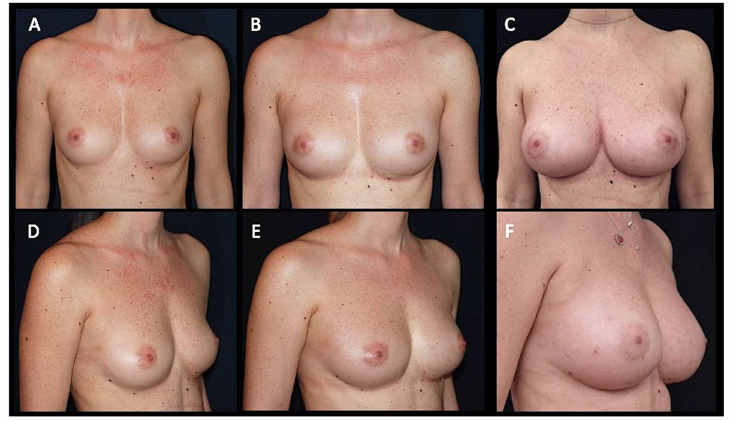
Figure 2. A 27 year-old-female, affected by a moderate grade of bilateral breast hypoplasia, was treated with autologous fat grafting. ( A ) Pre-operative projection in frontal view. ( B ) Post-operative projection in frontal view after six months (T5) and one procedure based on ASC-enriched AFG. An increase of 29.5 mm in the three-dimensional volume after 6 months (T5) was observed. ( C ) Post-operative projection in frontal view after 1 year (T6) and two procedures based on ASC-enriched AFG. An increase of 72.8 mm in the three-dimensional volume after 1 year (T6) was observed, evidencing a cosmetic result comparable with that obtained by the definitive implants. ( D ) Pre- operative projection in 3 / 4 right view. ( E ) Post-operative projection in 3 / 4 right view after six months (T5) and one procedure based on ASC-enriched AFG. ( F ) Post-operative projection in 3 / 4 right view after 1 year (T6) and two procedures based on ASC-enriched AFG evidencing the naturalness of the